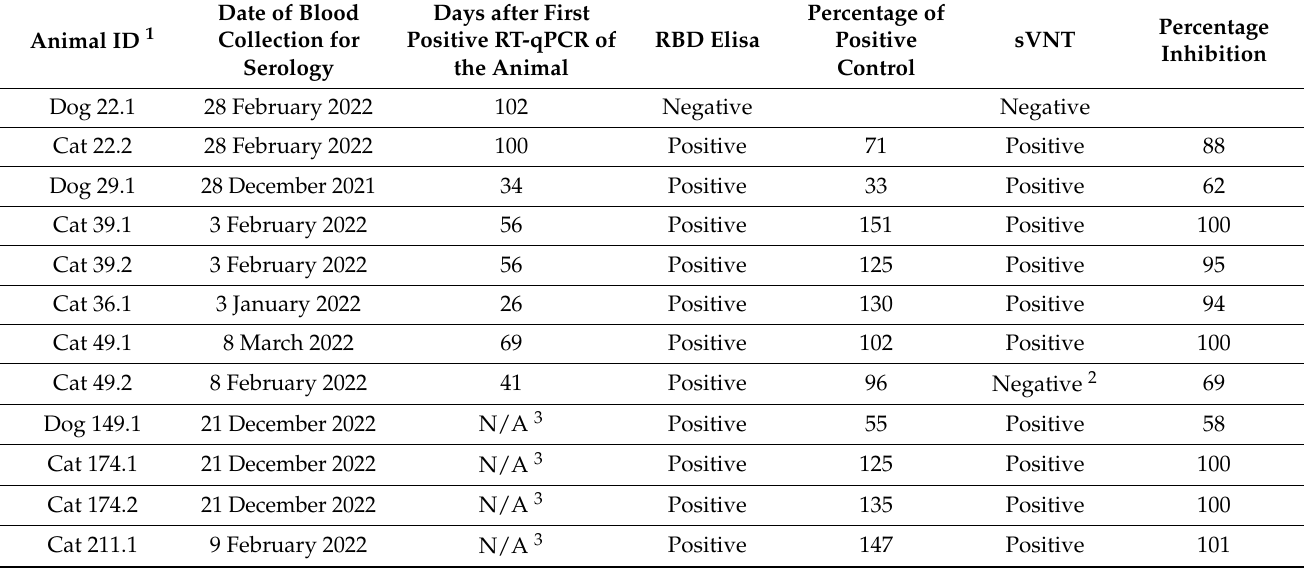
Table 4. Enzyme-linked immunosorbent assay that detects antibodies binding to the SARS-CoV-2 spike glycoprotein receptor-binding domain (RBD ELISA) and SARS-CoV-2 Surrogate Virus Neutral- ization Test Kit (sVNT) results in cats and dogs in COVID-19-affected